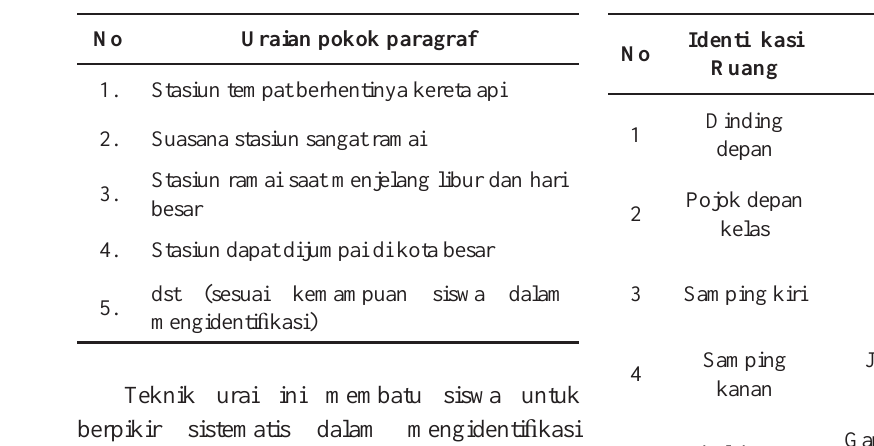
Tabel 1. Uraian Pokok Paragraf Tabel 2. Identifi kasi